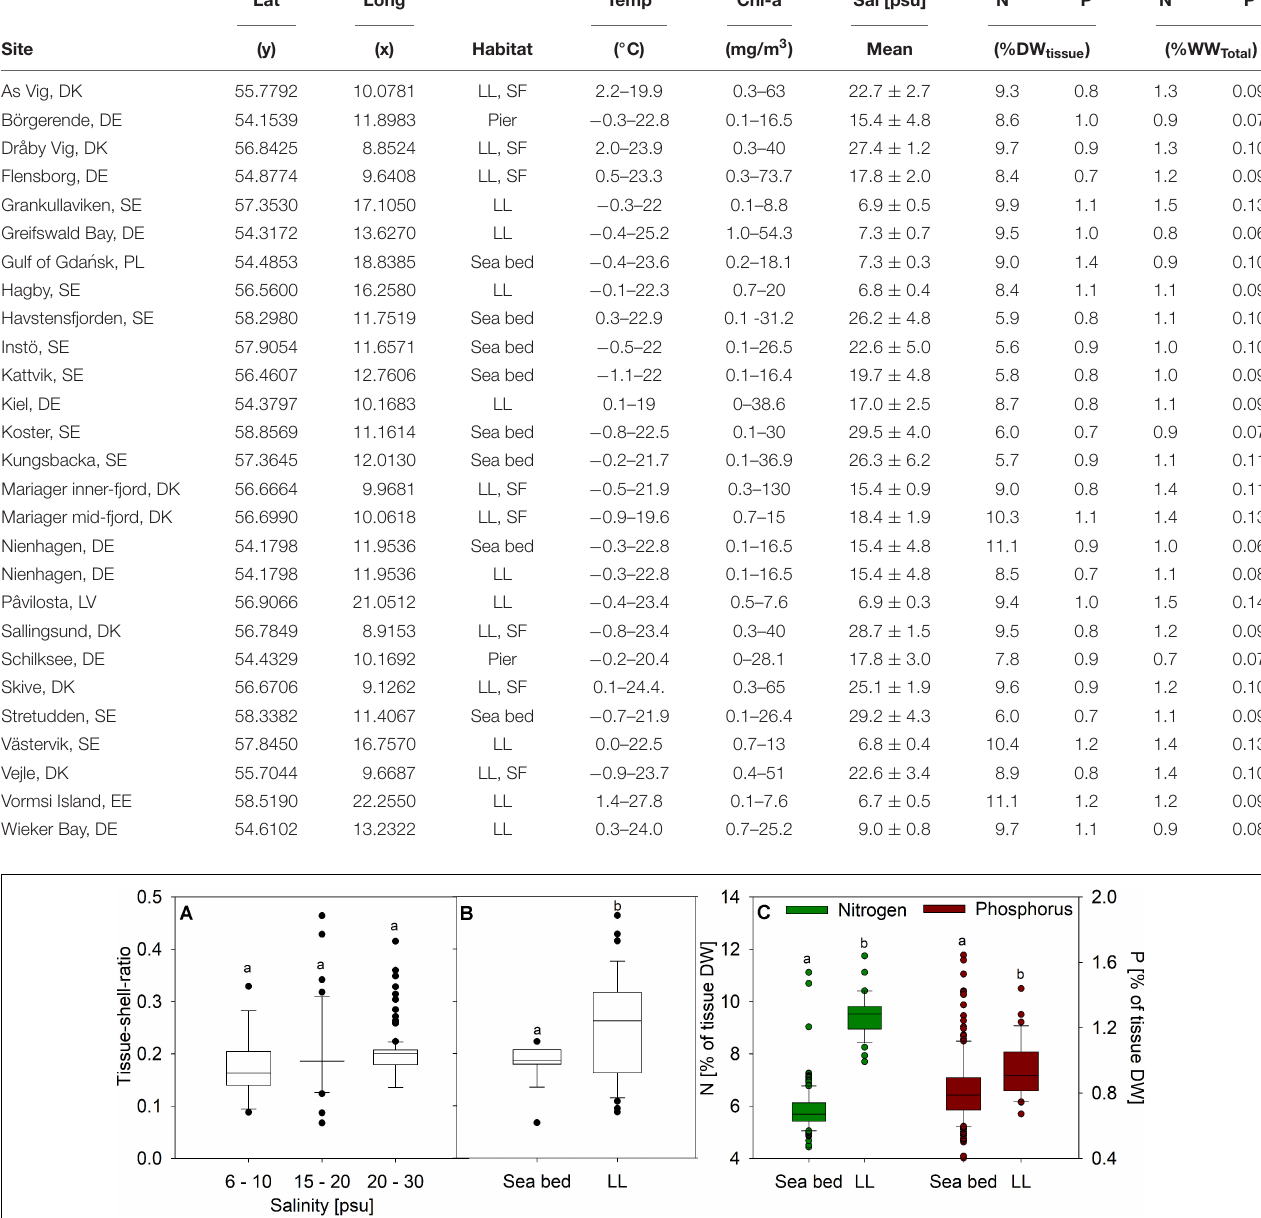
TABLE 1 | Sample locations, bivalve habitat (LL, longline; SF,Smartfarm), environmental parameters, and N&P contents in dry tissue mass (DW) as well as total wet weight (WW). Lat Long Temp Chl-a Sal [psu]